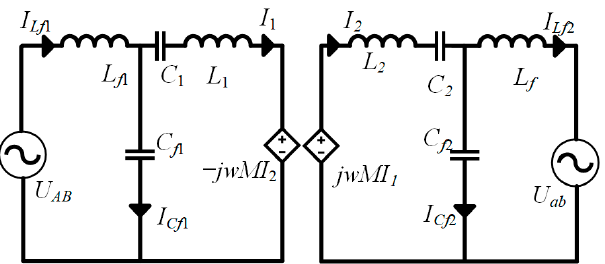
Figure 2. Mutual − inductance model-based analytical circuit of the LCC − LCC compensation topol- ogy.